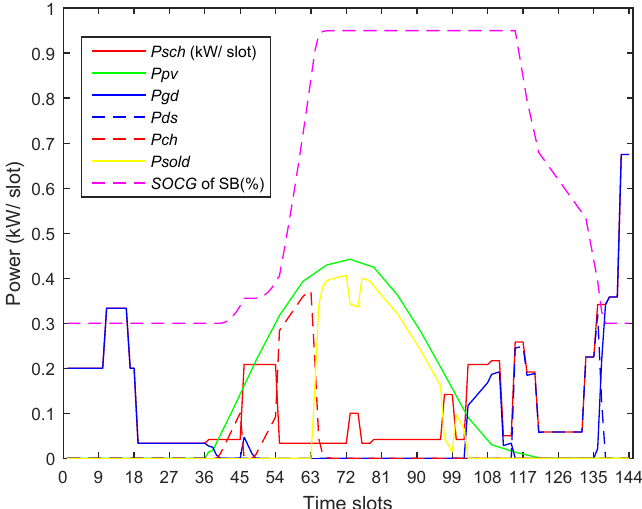
Figure 25. Load profile for maximal reduction in CE using CPP(DS) for PDDR-RED-based